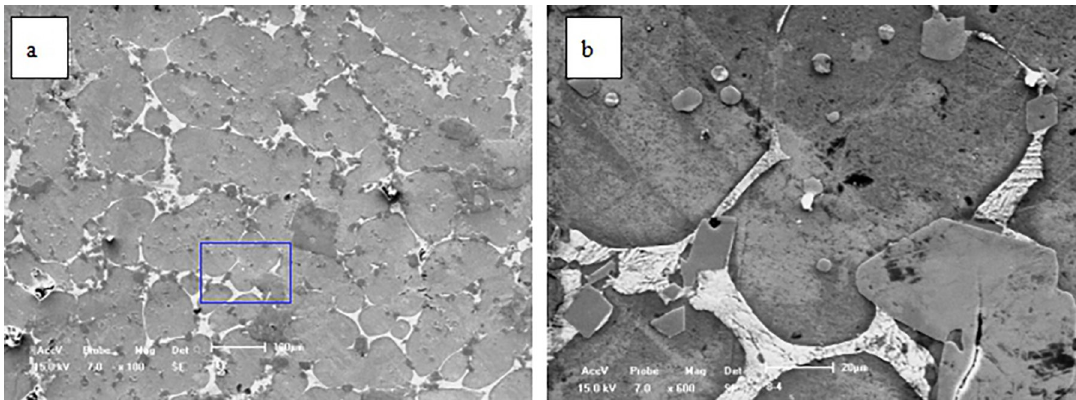
Figure 2. SEM images of A390-0.3wt%Nd alloy after heat treatment at different magnifications